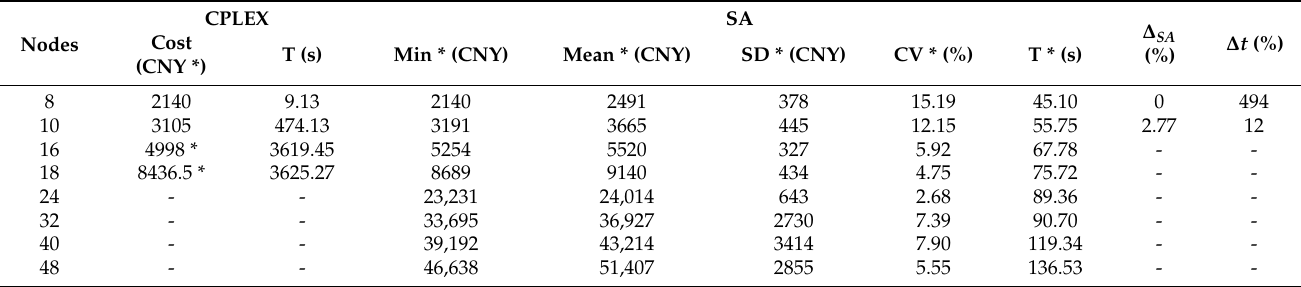
Table 3. Statistical results from CPLEX and SA (10 runs).